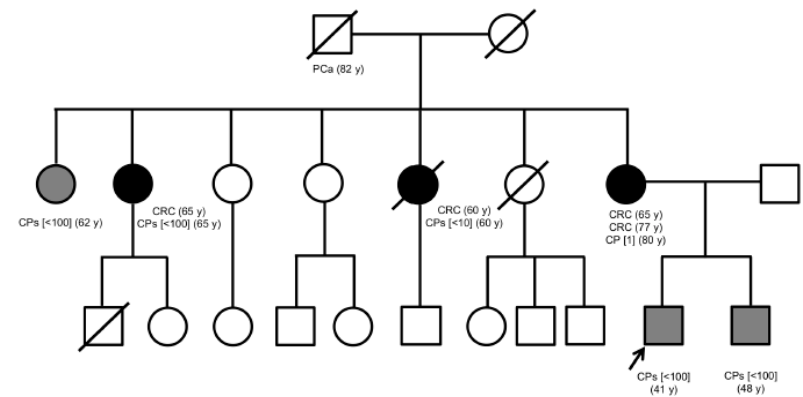
Figure 1. Pedigree of the Italian family involved in this study. Squares indicate men, circles represent women. The arrow indicates the index case. Unfilled symbols indicate unaffected individuals. Slashed symbols denote dead individuals. Black-filled symbols denote individuals with colorectal cancer and polyposis, while gray-filled symbols correspond to patients with colorectal polyposis. The following information is given below each filled symbol: clinical manifestations (CRC = colorectal cancer; CPs = colon polyps, with the number of polyps indicated in square brackets; Pca = prostate cancer), age at diagnosis (y = years).